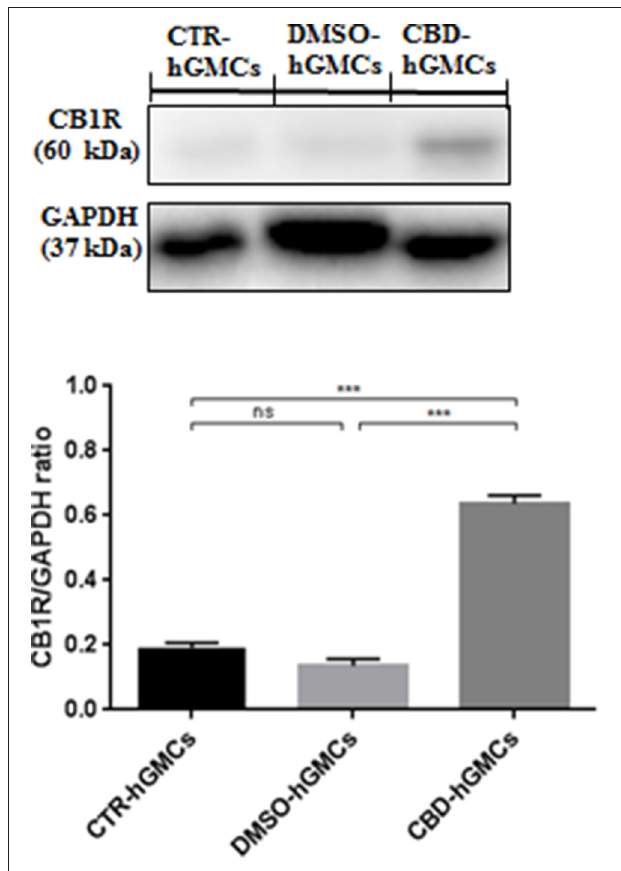
FIGURE 5 | Western blot analysis for CB1R. CB1R expression is increased in CBD-hGMSCs compared to control groups (DMSO-hGMSCs and CTR-hGMSCs). *** p < 0.001. ns, no statistical